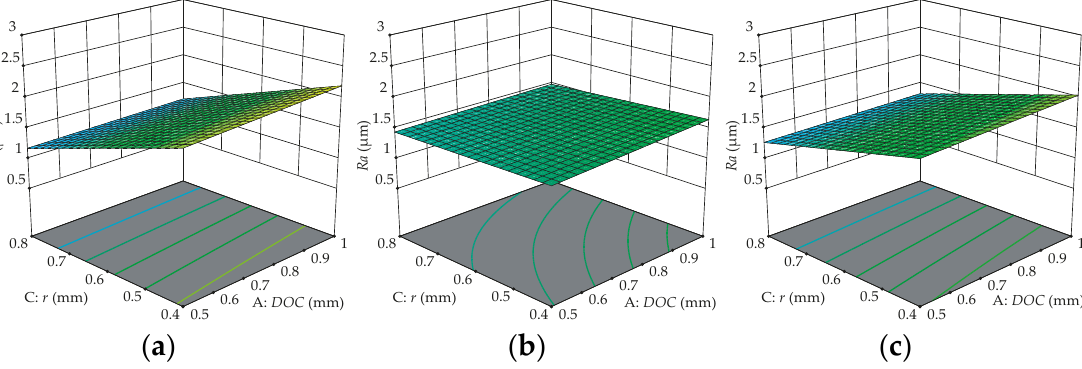
Figure 11. Predicted effect of nose radius and depth of cut on Ra surface roughness for cutting tools: ( a ) WC/PVD; ( b ) WC/CVD; ( c ) Cermet/PVD. Materials 2020 , 13 , x FOR PEER REVIEW